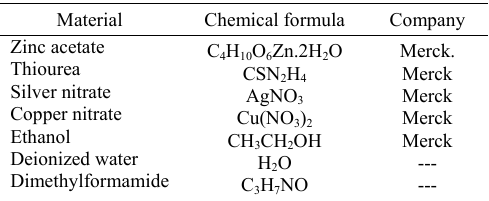
Table 1. list of materials used in